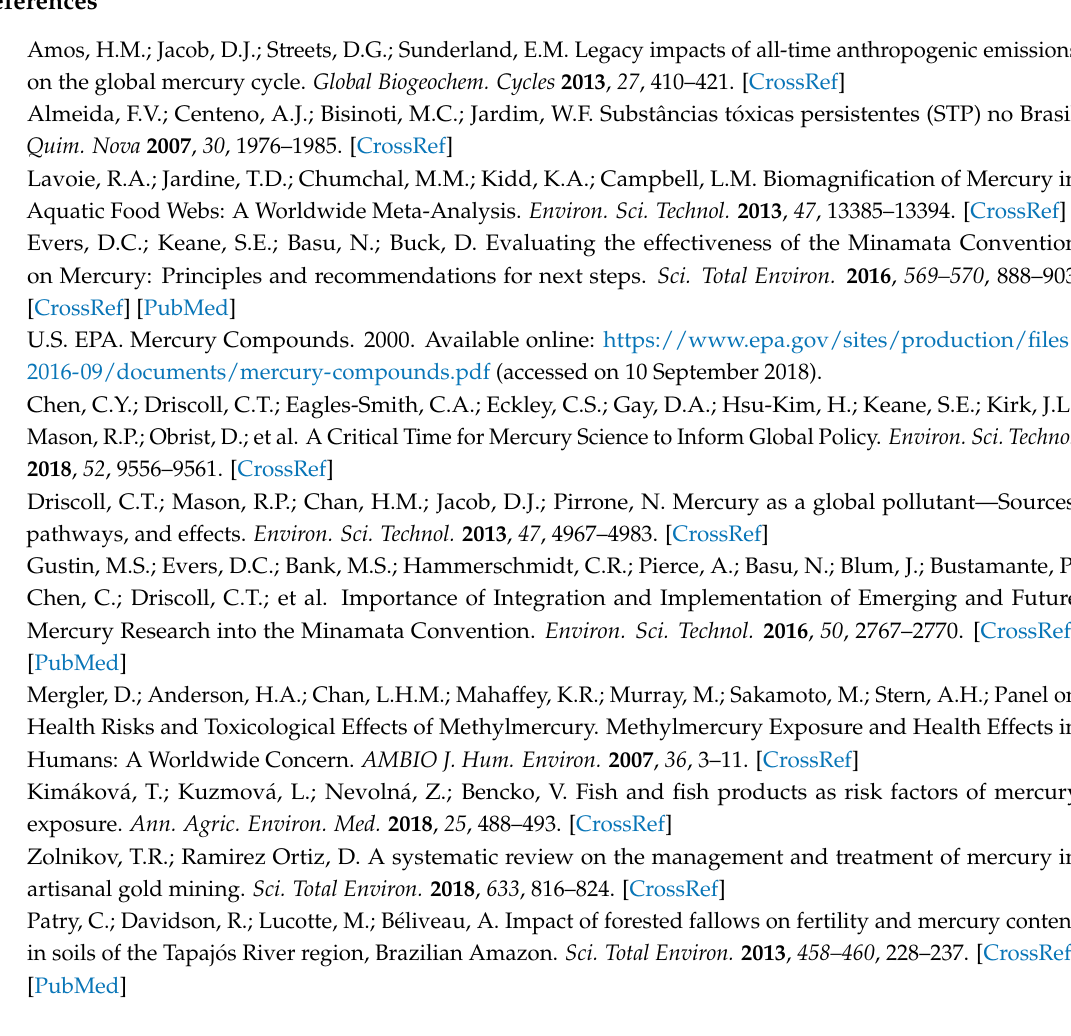
Figure A1. Reference networks about mercury research in the Amazon between 1991 and 2017. The colors represent the clustering between them.